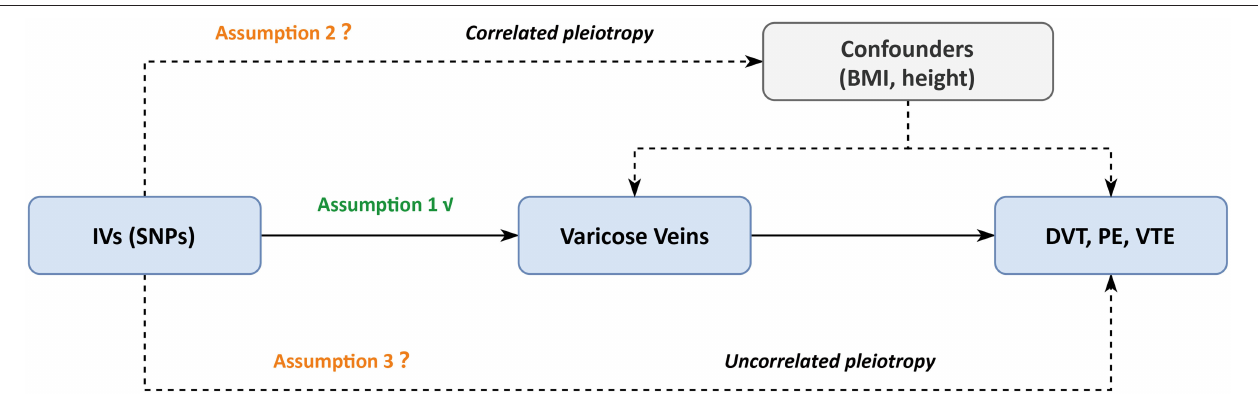
FIGURE 1 | Mendelian randomization model in this study. BMI, body mass index; DVT, deep vein thrombosis; IV, instrumental variables; PE, pulmonary embolism; SNP, single-nucleotide polymorphism; VTE, venous thromboembolism. Assumption 1: the genetic variants should be associated with exposure. Assumption 2: the genetic variant should not be associated with confounders of the exposure-outcome relationship. Assumption 3: the genetic variants exert effects on the outcome only via the